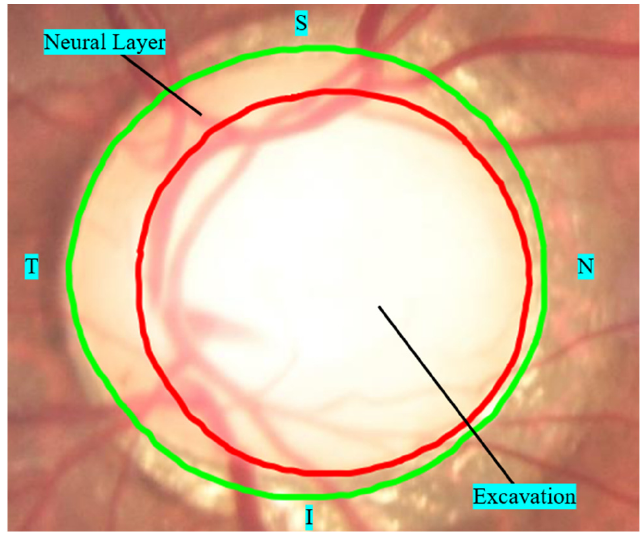
Figure 3. Optical papilla zone.